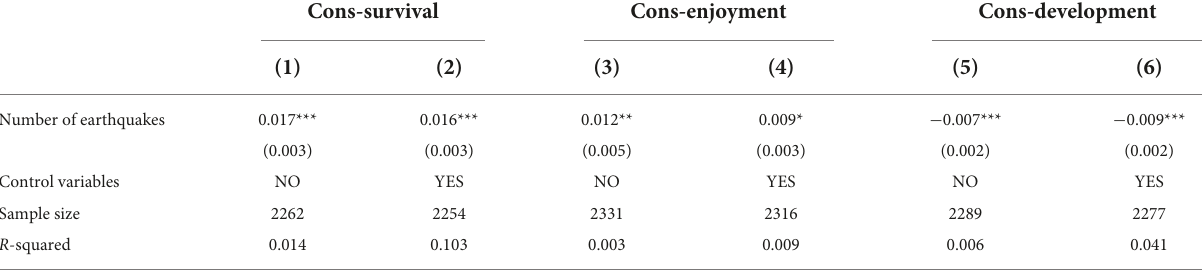
TABLE 3 Earthquakes and different types of